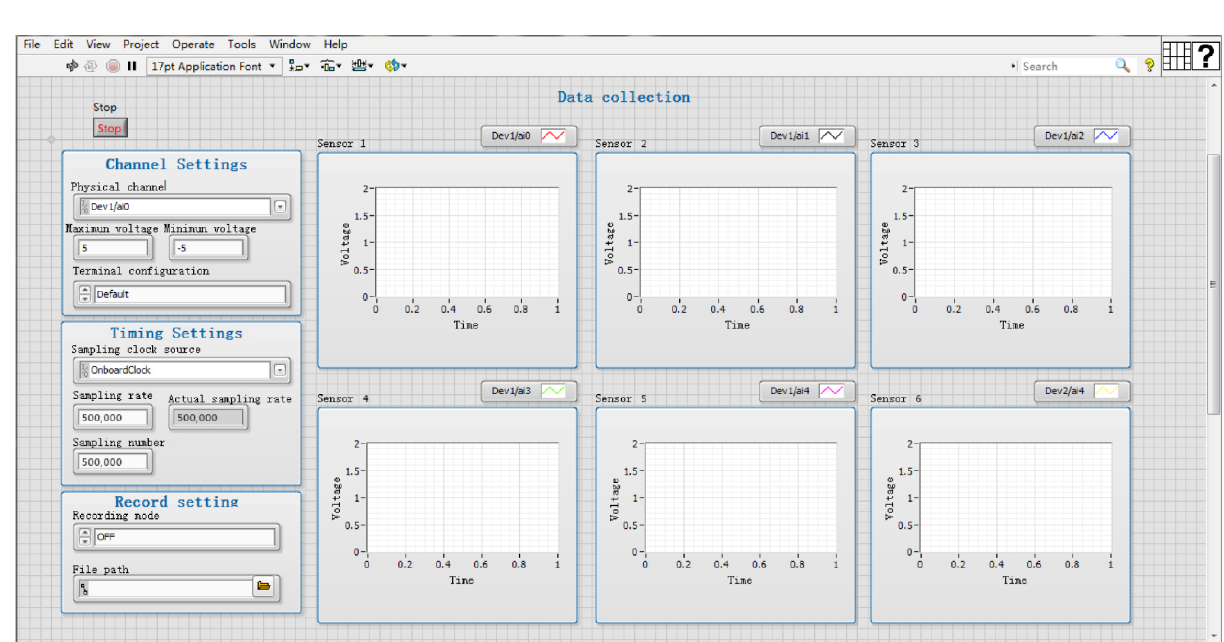
Figure 1. Test parameters.